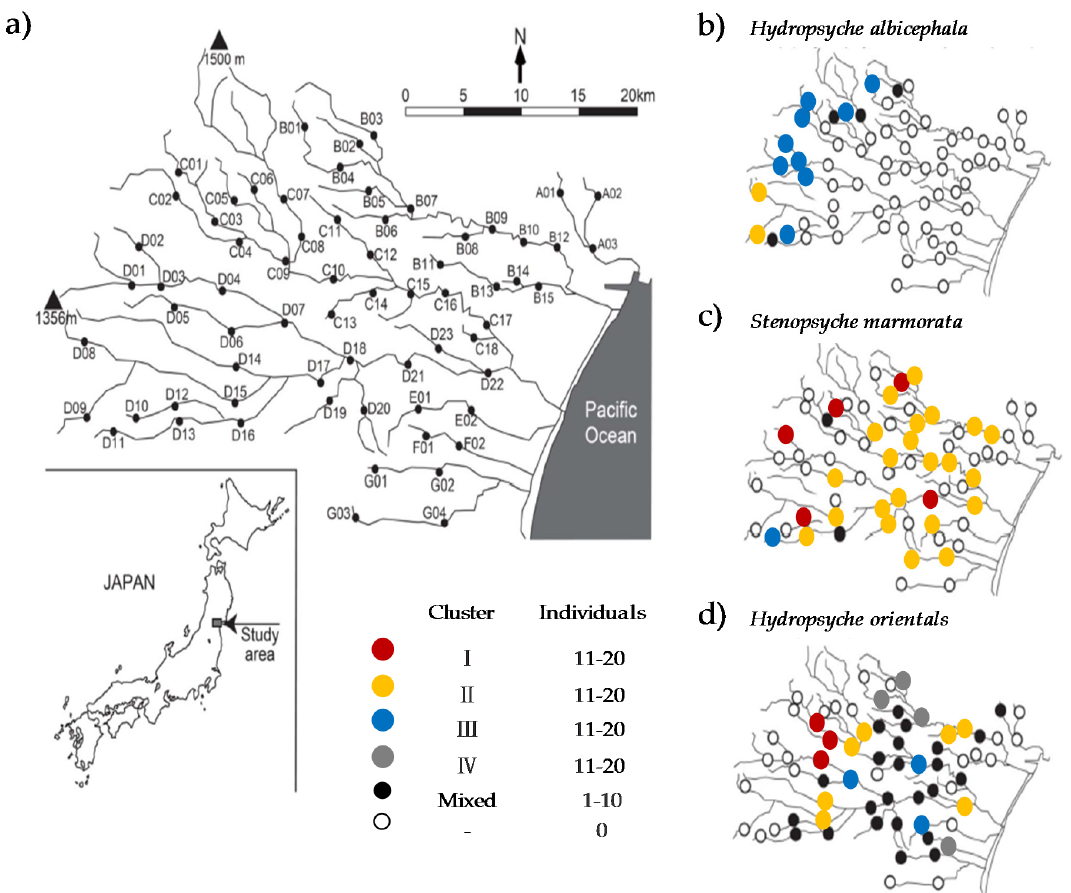
Figure 1. ( a ) Map of sampling sites; ( b ) group size of individuals collected within same cluster at each sampling site according to SOM (Figure 4) for Hydropsyche albicephala ; ( c ) Stenopsyche marmorata , ( d ) Hydropsyche orientals . The color of the solid circles indicates a cluster in which 11 or more individuals (the total number of individuals in one site was 20) were grouped together, whereas the black circles mean the individuals are equal to or less than 10. The white circle stands for no individual collected at the sampling sites. The symbols, I, II, III and IV, in the legend indicate cluster names shown in Figure 4. Modified from Watanabe et al. [8].